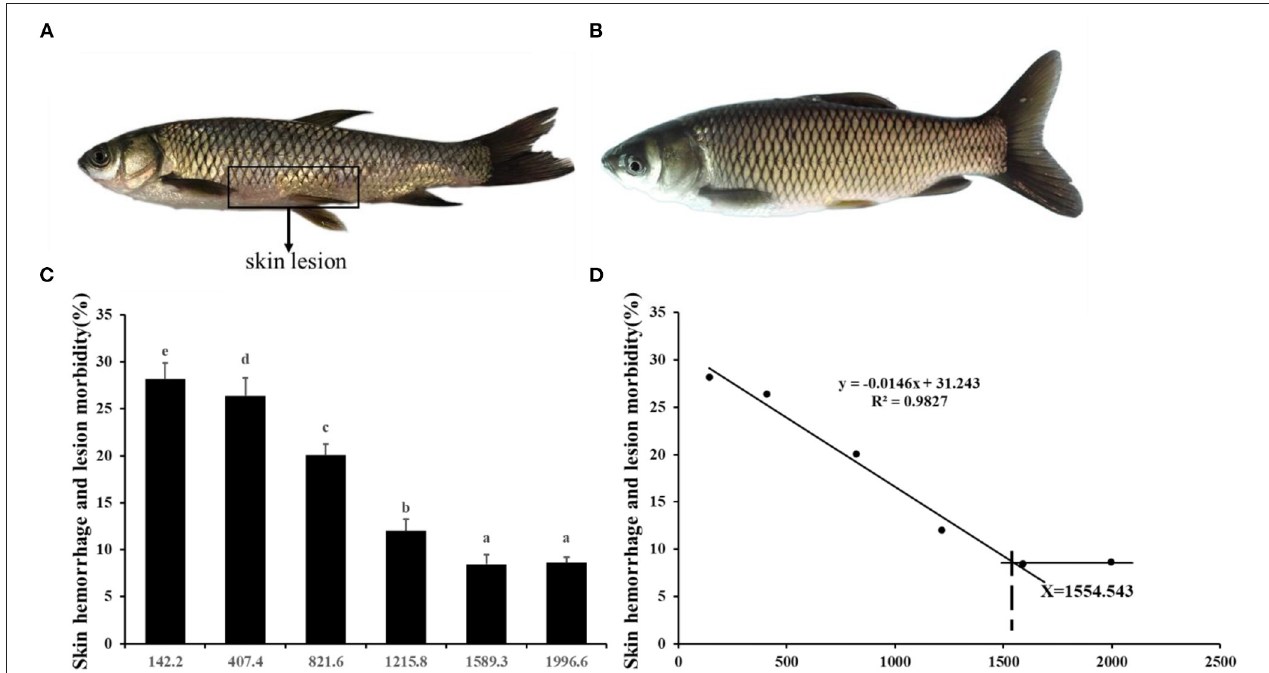
FIGURE 2 | Effects of dietary choline level (mg/kg diet) on skin rot morbidity of juvenile grass carp ( Ctenopharyngodon idella ) after infection with A. hydrophila . (A) 142.2 mg/kg diet. (B) 1589.3 mg/kg diet. Values are means, and standard error of the mean represented by vertical bars. N = 6*5 for each choline level. Values having different letters are significantly different ( P < 0.05). (C) Skin hemorrhage and lesion morbidity (%). (D) Choline requirement is assessed by morbidity.